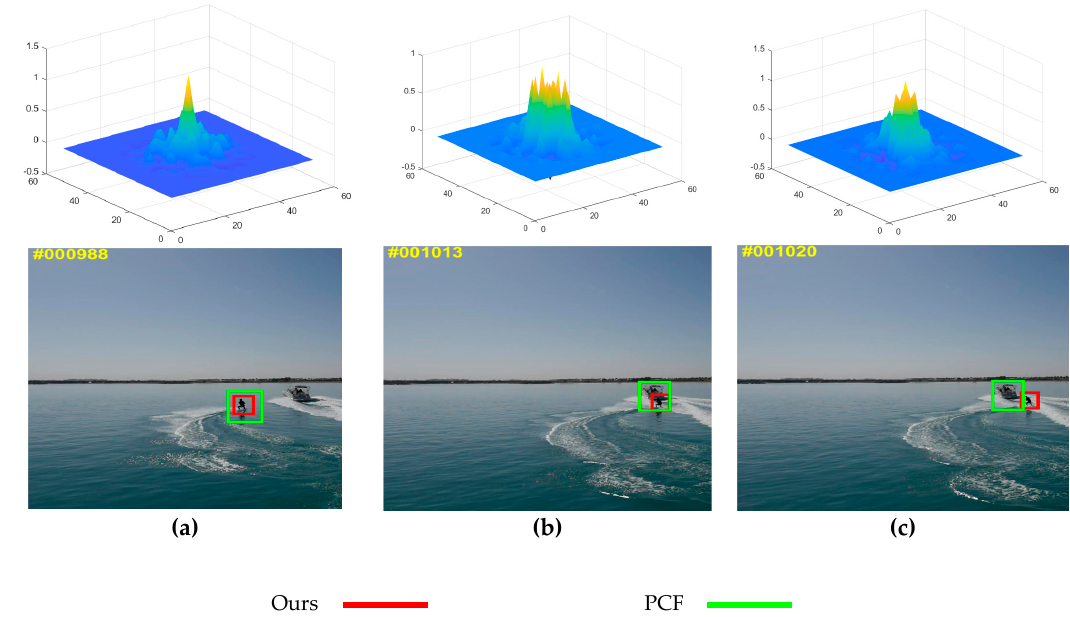
Figure 1. Comparison of the peak distribution of the PCF tracker and the proposed tracker when occurring occlusion. The red one is the proposed tracker and the green one is the baseline tracker PCF. There are three status: ( a ) The object has not affected by interence; ( b ) The object has affected by interence; ( c ) The object gradually breaks away from the interence.